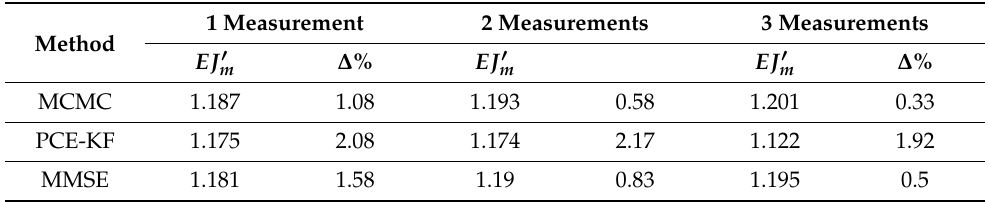
Table 4. Performance of the different updating procedures: comparison of posterior mode EJ (cid:48) m and EJ true = m + s =